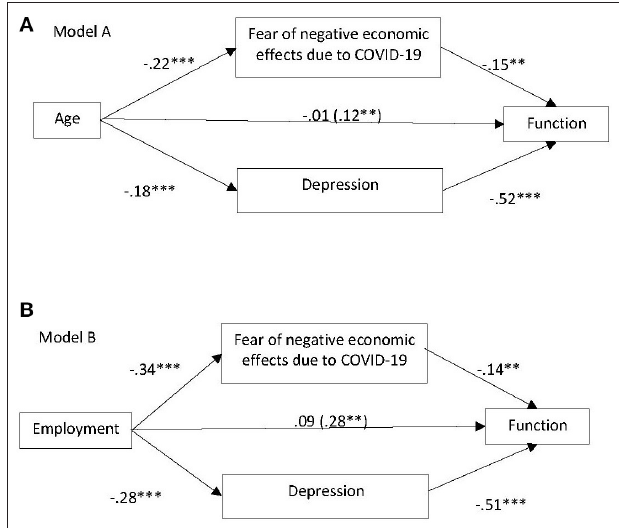
FIGURE 4 | Mediation of economic fear and depression on (A) the relationship between age and function; (B) the relationship between employment and function. * p < 0.05, ** p < 0.01, *** p <